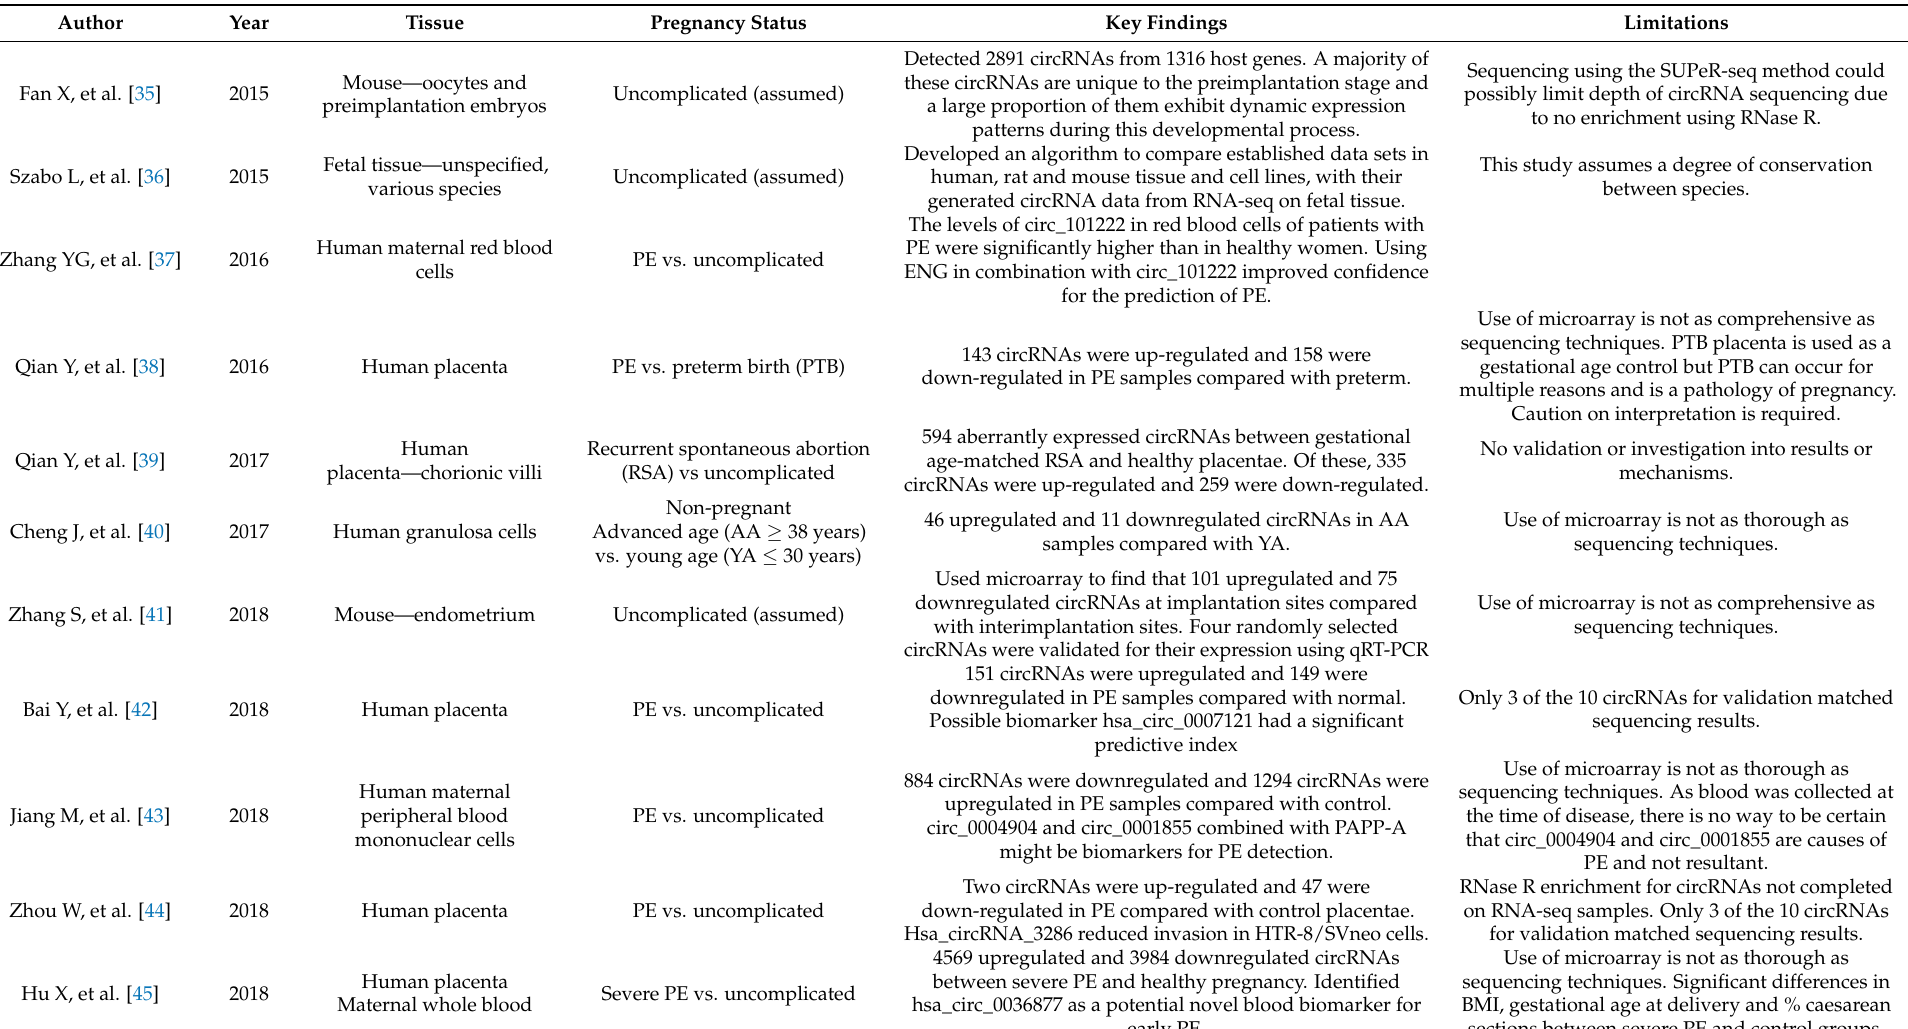
Table 1. Summary of research on circRNAs in female reproductive tissues and blood during pregnancy (limited to studies using primary